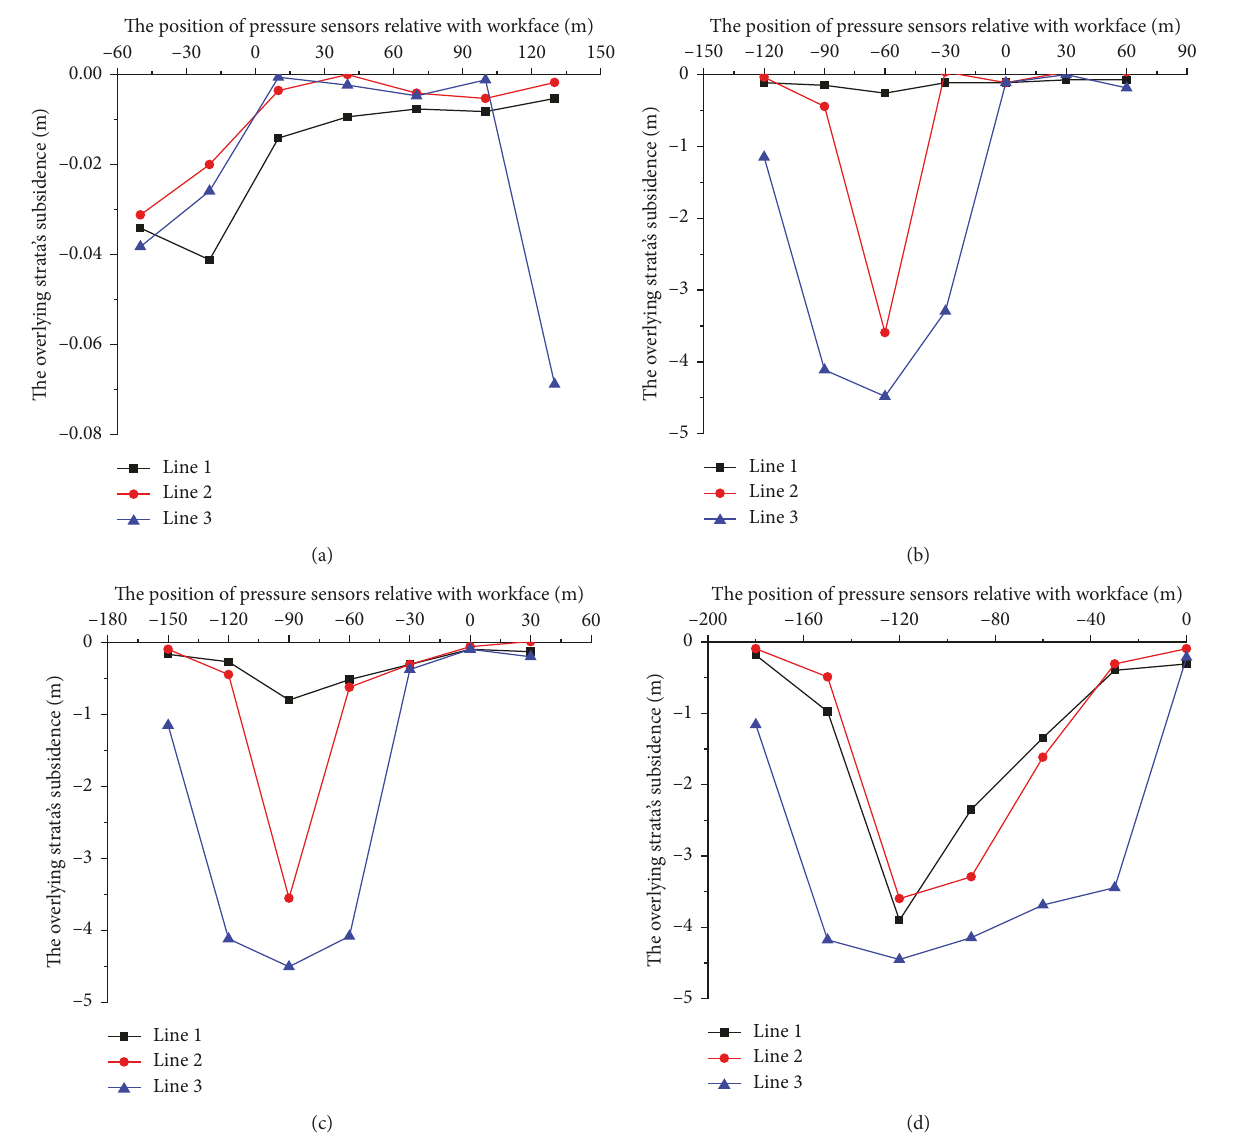
Figure 6: The varying curves of the overlying strata’s subsidence during excavation. The coal stratum is excavated to (a) 60m, (b) 130m, (c) 160m, and (d)